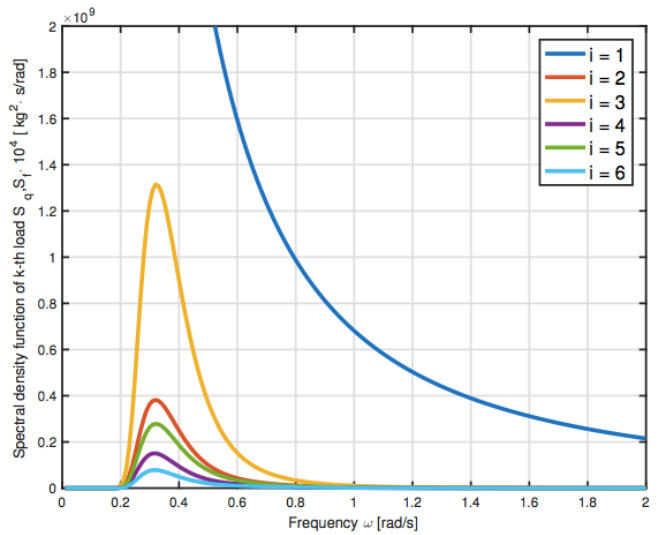
Figure 20. Mooring line spectral density of the generic environmental load in modal coordinates.